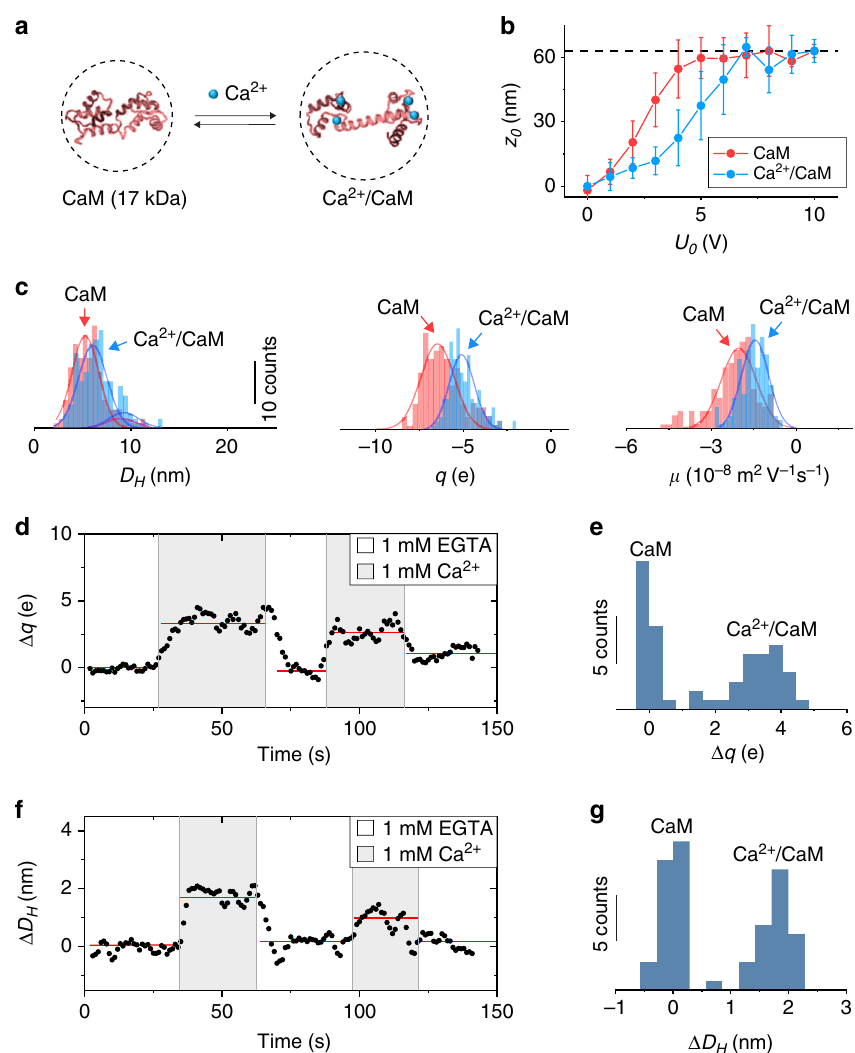
Fig. 3 Ligand binding-induced conformation change in a protein. a Binding of Ca 2 + to calmodulin (CaM) causes conformation and charge changes in CaM. b Oscillation amplitude vs. U 0 plots before (red) and after (blue) Ca 2 + binding to CaM, where the vertical bars are standard deviations of >150 CaM or Ca 2 + /CaM molecules. c Statistical analysis for 150 CaM molecules (red) and 151 Ca 2 + /CaM molecules (blue) showing the diameter ( D H ), charge ( q ) and mobility ( µ ) distributions of CaM and Ca 2 + /CaM complex (see Supplementary Table 4 for a summary). The red and blue lines are Gaussian fi ttings of the peaks. d , f Tracking of the charge ( Δ q ) and size ( Δ D H ) changes of a single CaM molecule induced by Ca 2 + binding over time, where the size change was measured with U 0 fi xed at 7 V (the plateau regime) and the charge measurement was performed with U 0 = 4 V (the linear regime). The binding and unbinding of Ca 2 + to CaM were performed by alternatively fl owing 1 mM EGTA and 1 mM Ca 2 + in 100× diluted PBS (at pH = 7.4) over the surface. The scatter plots (black dots) are raw data smoothed over three points, and the red lines are guide to the eye, showing the charge or size change duo the binding and unbinding of the molecule with Ca 2 + . e , g Charge and size histograms obtained from the fi rst binding and unbinding cycle in d , f respectively. Both histograms show two peaks corresponding to the CaM molecule with and without Ca 2 +